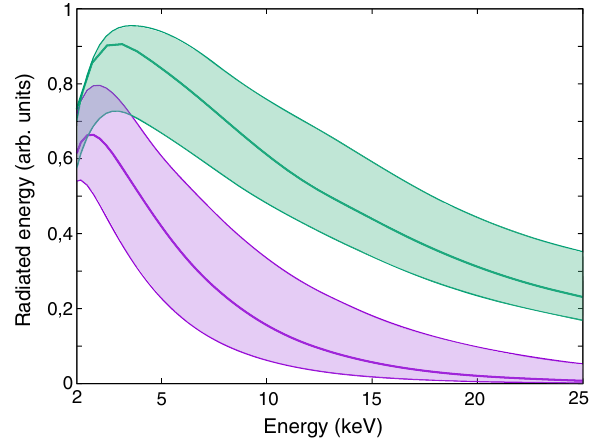
FIG. 3. Measurements of the betatron radiation spectra for a constant density plasma (purple) and for an up-ramp density plasma (green). The shaded area represents the intervals of betatron spectra that fit the x-ray signal measured through metallic filters. The thick solid lines within these areas are the fits obtained from particle-test simulations. Only the density gradient, set as initial condition, distinguishes the two cases in the numerical simulation. The experimental measurements and numerical fit agree and demonstrate that a longitudinal density gradient enhances the energy and flux of the betatron radiation. The critical energy E c characterizing the spectrum shifts from 5 to 10 keV.